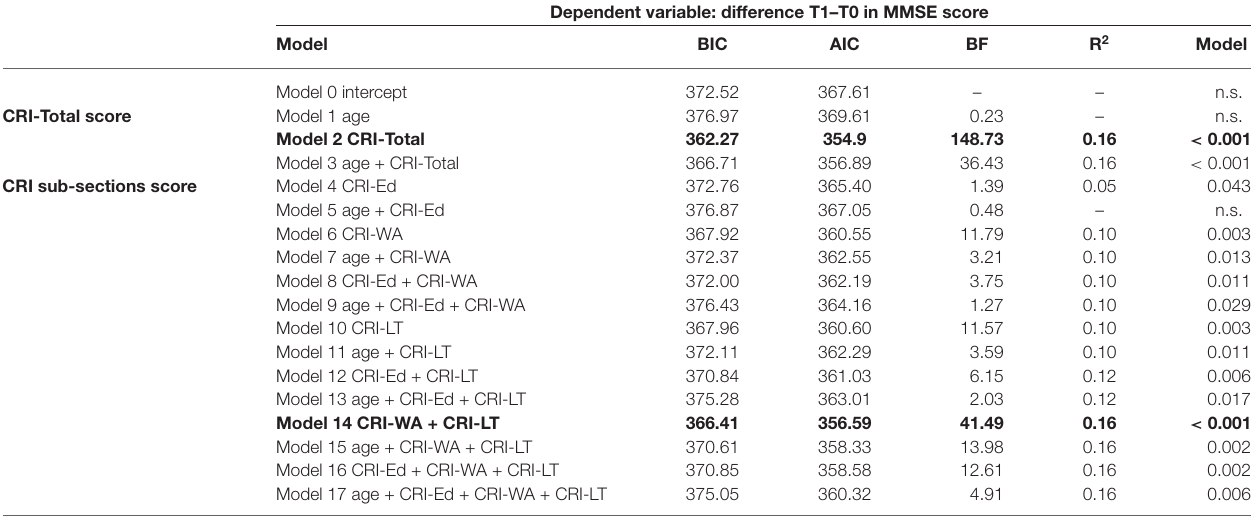
TABLE 3 | Linear regression models compared through BIC, AIC, BF and R 2